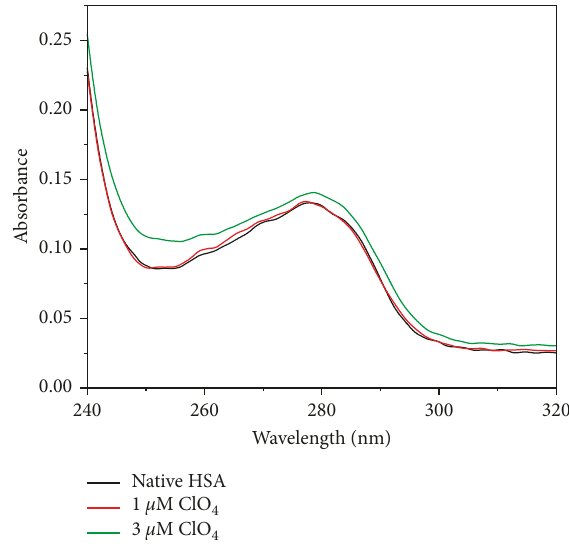
Figure 2: UV absorption difference spectra of HSA (5 µ M). These spectra represent the effect of compound 1 at 1 µ M and 3 µ M concentrations. (The difference spectrum was obtained by the HSA-Ag compound spectra minus Ag compound